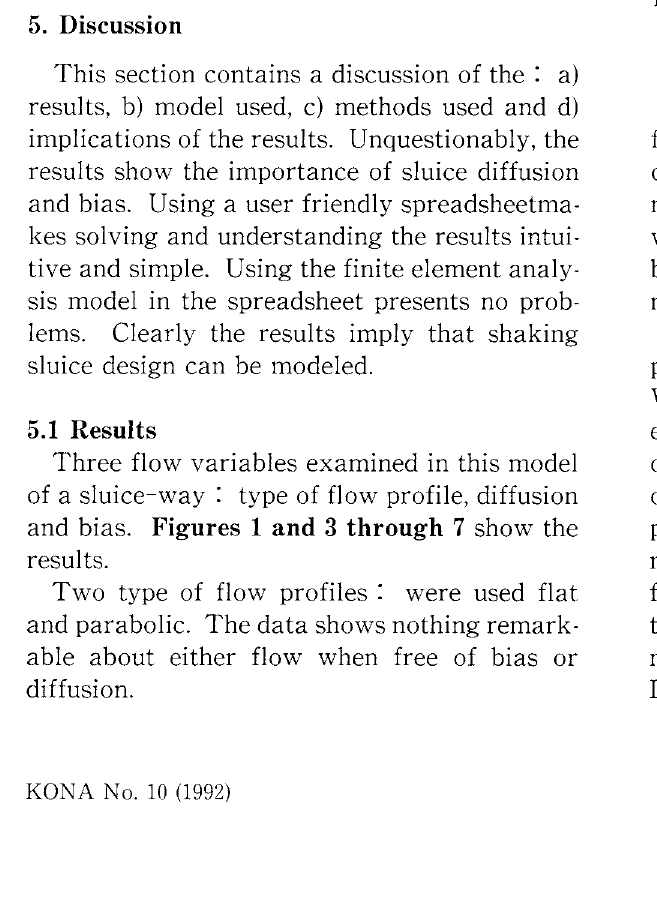
Fig. 6a Flat profile, high diffusion & bias. Time 300, 900 seconds.